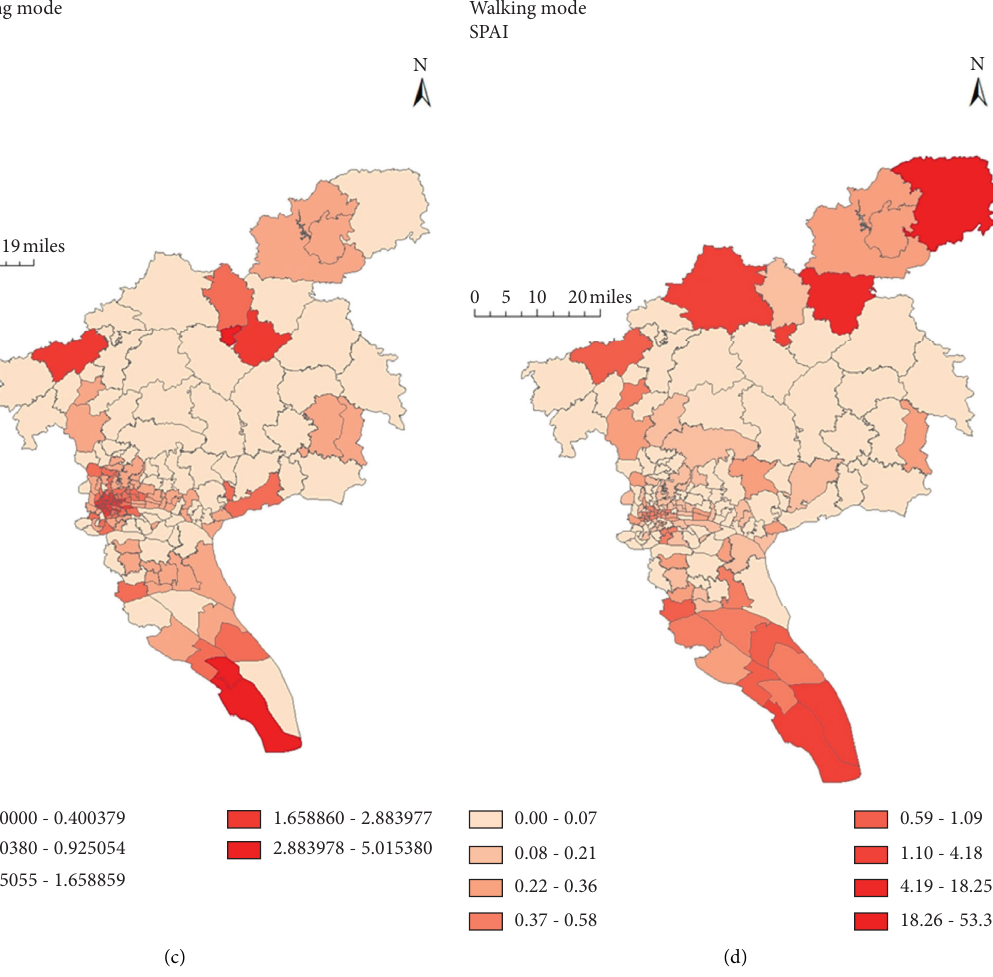
Figure 3: Accessibility distribution of medical facilities in multiple traffic modes. Table 4: SPAR description statistics in different traffic